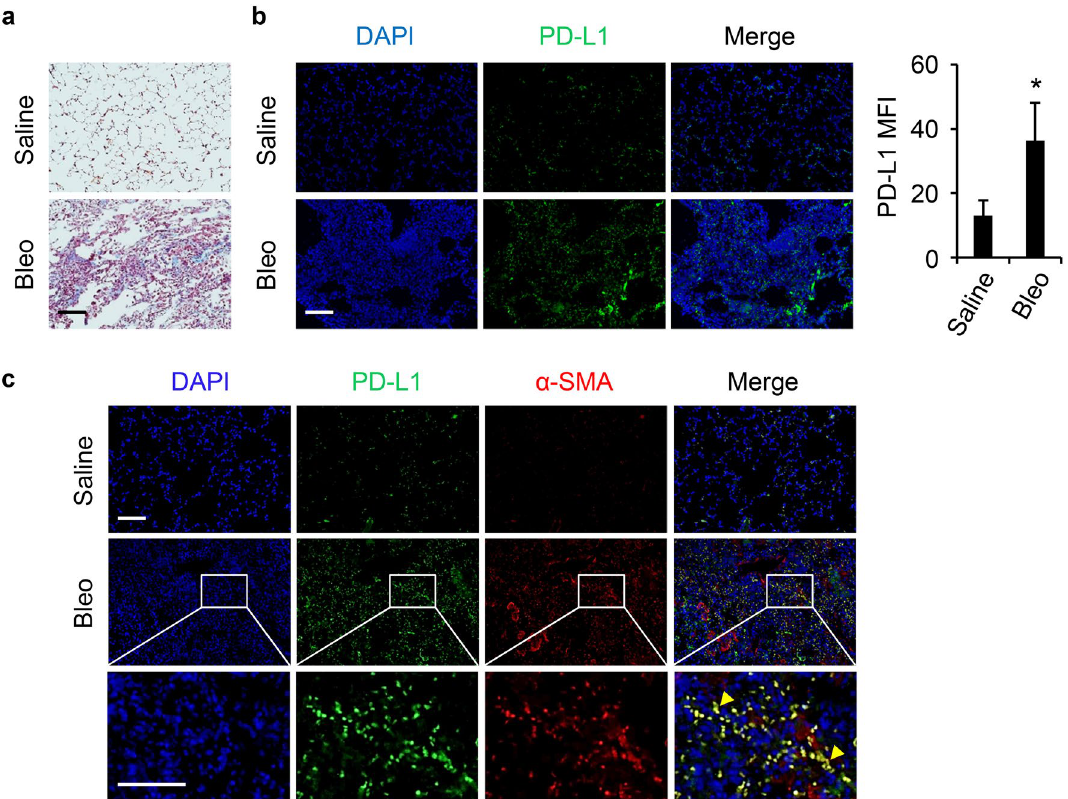
Figure 2. PD-L1 expression was induced in bleomycin induced pulmonary fibrosis in vivo. ( a ) Masson’s trichrome staining showed increased lung collagen deposition in mice given bleomycin (Bleo) for 3 weeks. ( b ) IF staining showed significantly increased lung PD-L1 (green) in mice received intratracheal Bleo. The quantification and comparison of PD-L1 mean fluorescence intensity (MFI) was based on measurements from 10 representative fields per slide/mouse, n = 3 mice per group. MFI, mean fluorescence intensity. *, P < 0.05 compared with corresponding control group. ( c ) Representative IF images showing co-staining of PD-L1 (green) and α-SMA (red) in lung tissues of mice received saline or Bleo. Bars (black and white) represent 100 µm. Enlarged views (white squares) are shown below to indicate co-staining of PD-L1 and α-SMA by yellow arrowheads. n = 3 mice per